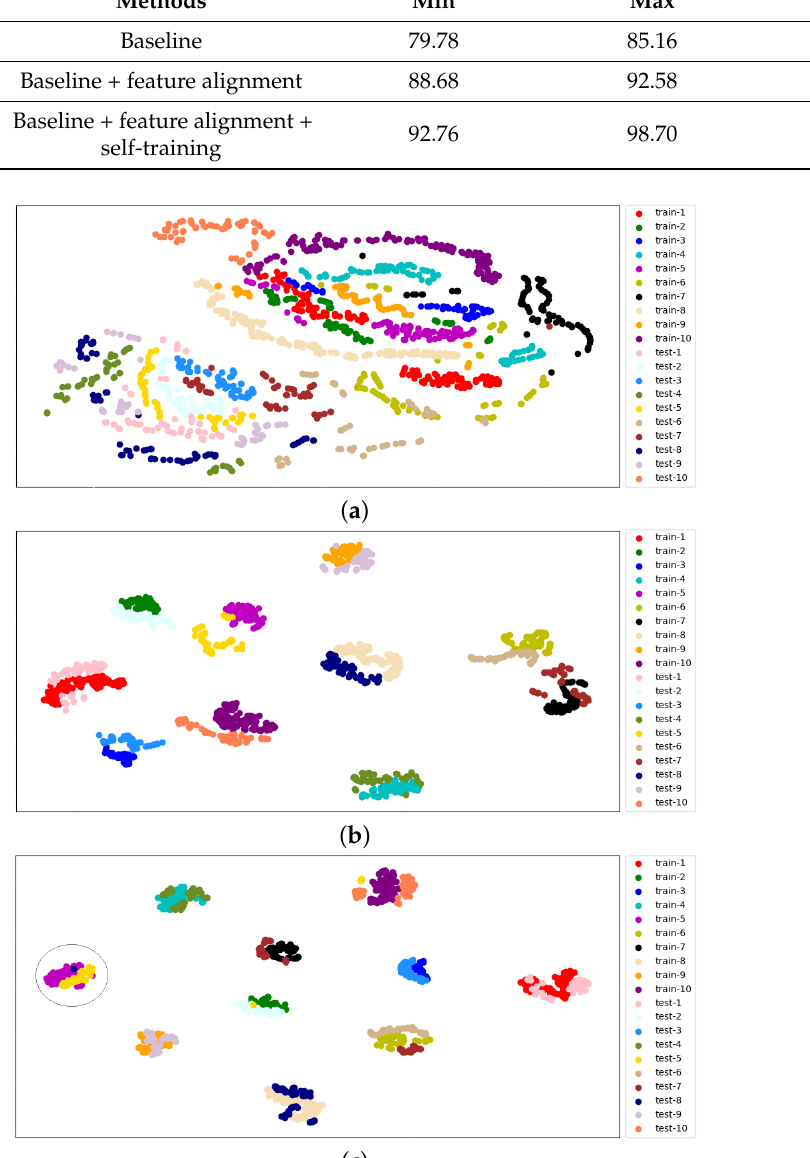
Figure 10. T-SNE visualization results of data distribution under Training Scenario II. ( a ) Original data distribution. ( b ) Feature distribution after feature alignment classification. ( c ) Feature distribution after feature alignment and